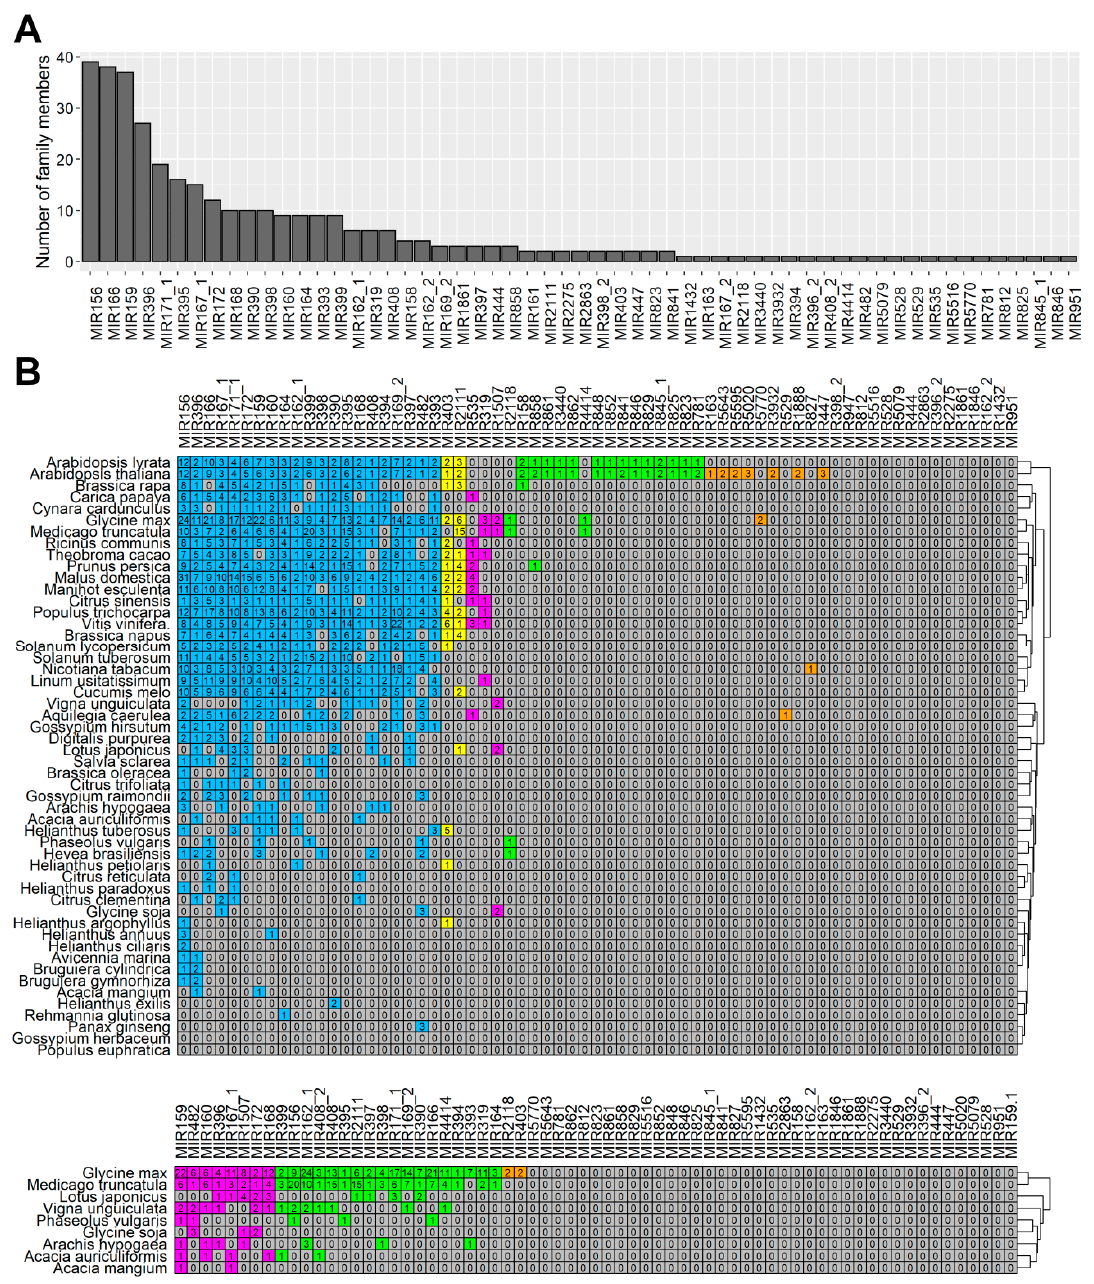
Figure 3. Identification and evolutionary conservation of known miRNA families in Lupinus luteus . ( A ) The distribution of known miRNA family sizes in L . luteus . ( B ) Comparison of known miRNA families in L . luteus and their 52 homologs in Eudicotyledons species present in miRBase (upper panel) and 9 Fabaceae species (lower panel). Known miRNA families of L . luteus identified from small RNA-seq are listed in the top row. The colors represent relative miRNA families classified into different groups with similar conservation. Blue, yellow, magenta, green and orange represent relative miRNA families with homologs across more than 20, 10–19, 5–9, 2–4 species and in 1 species, respectively.